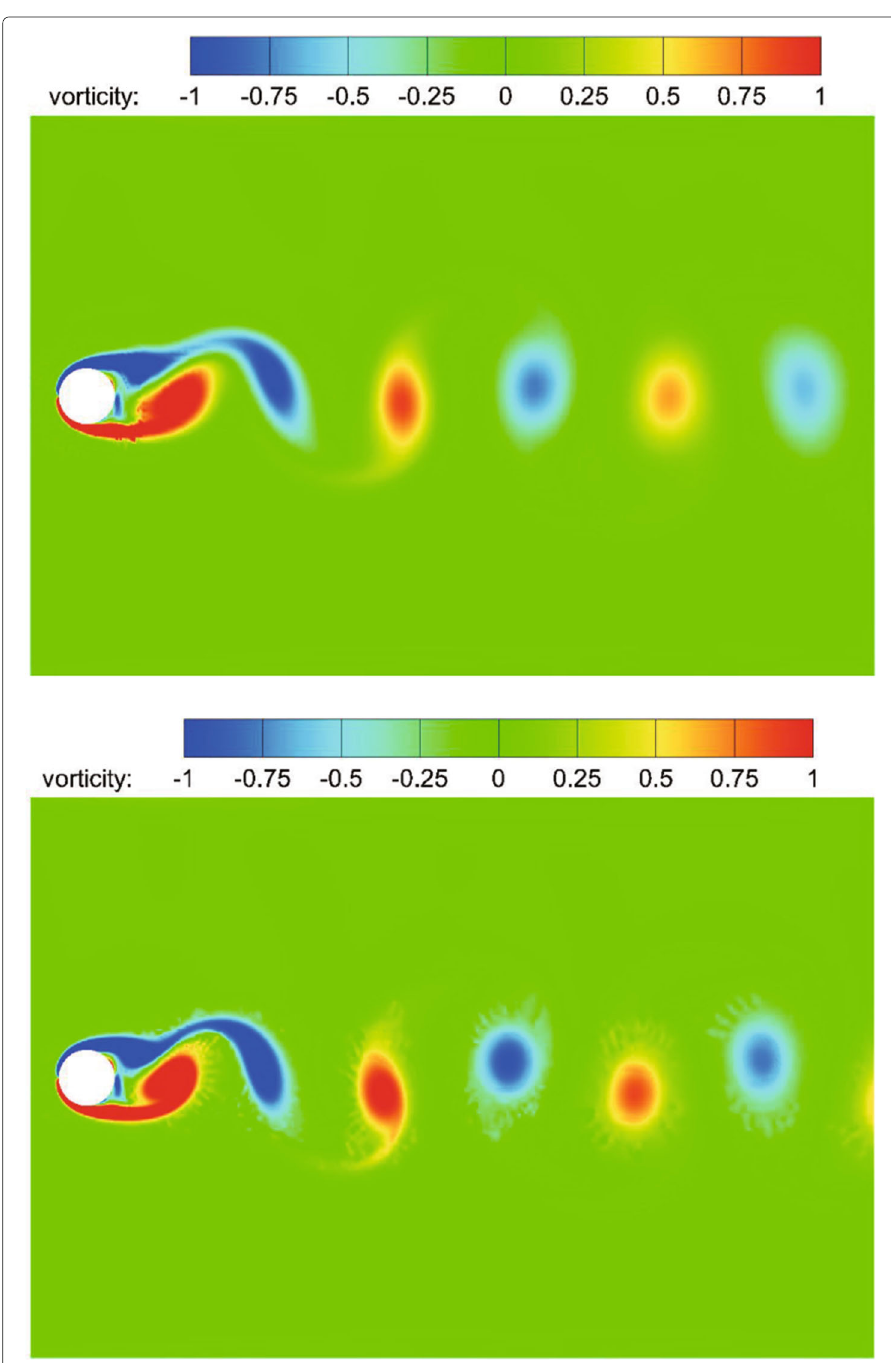
Fig. 20 Instantaneous vorticity contours for flow around a cylinder. Top: without solution-based refinement. Bottom: with three times solution-based